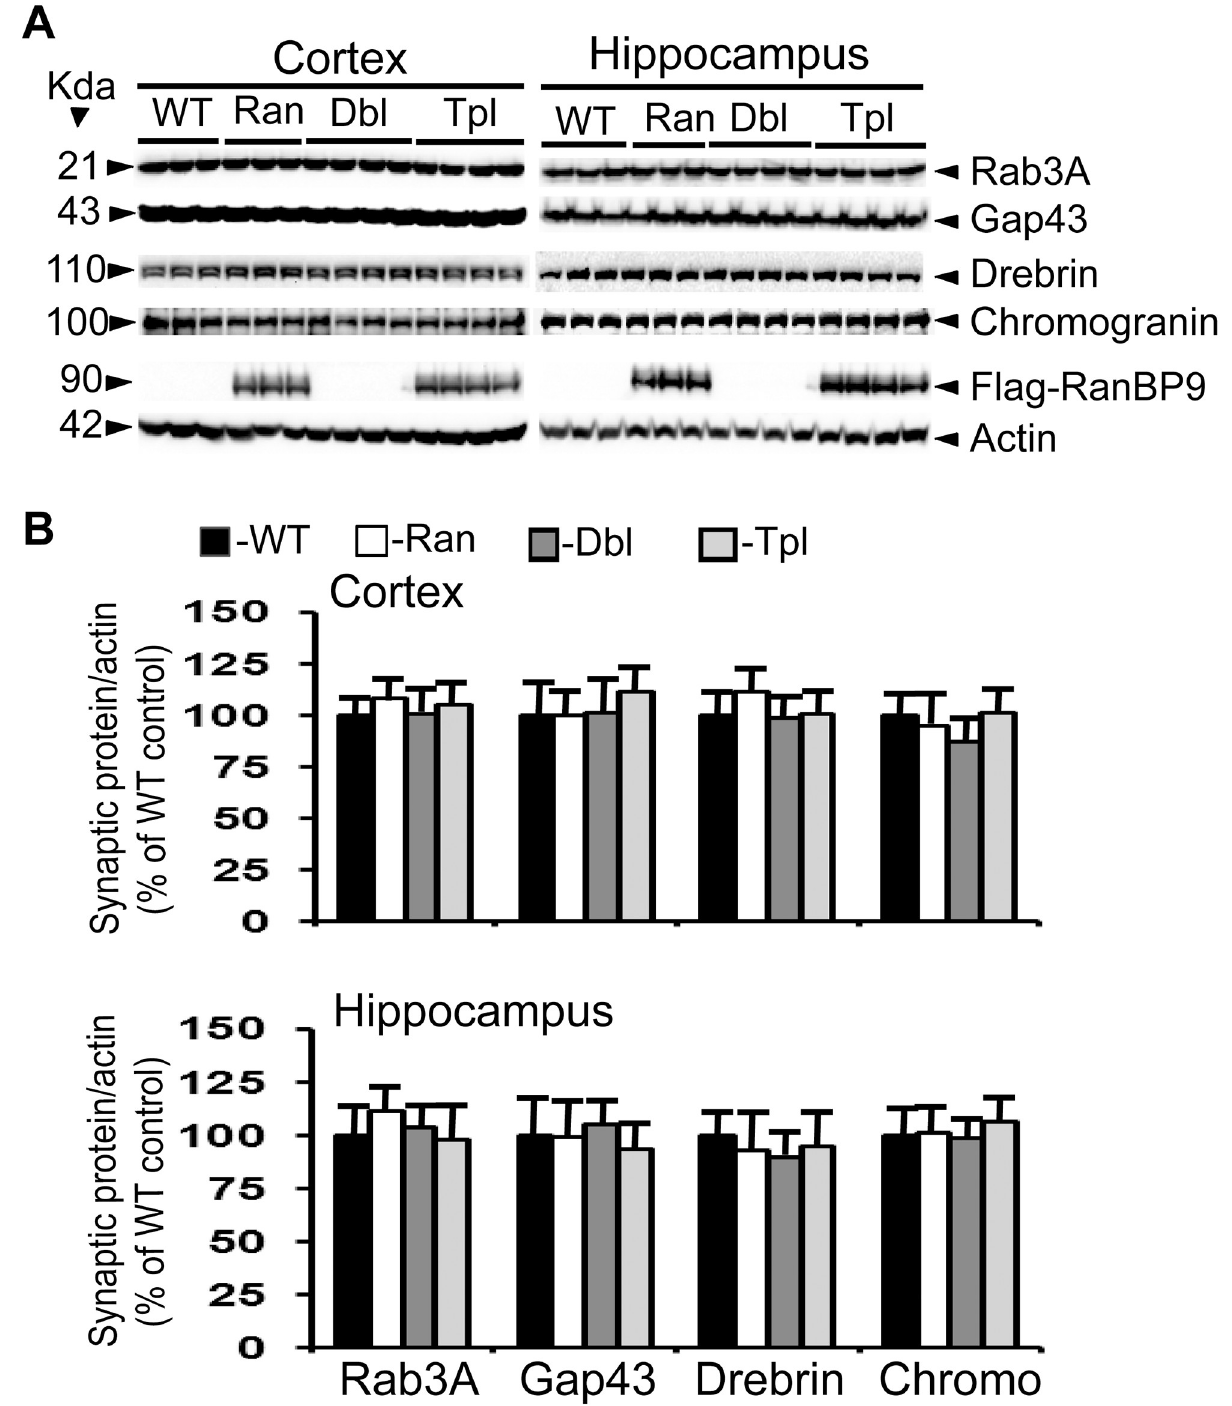
Fig 1. RanBP9 overexpression does not alter synaptic protein levels in the cortex and hippocampus at 3- months of age. A: Shows an immunoblotting analysis of rab3A, gap43, drebrin, chromogranin and the house keeping gene actin in brain samples from cortex and hippocampus. Brain homogenates from RanBP9 transgenic (Ran), AP Δ E9 double transgenic (Dbl), AP Δ E9/RanBP9 triple transgenic (Tpl) and age-matched wild-type (WT) control mice at 3-months of age were subjected to SDS-PAGE electrophoresis and probed with their respective antibodies. Flag specific monoclonal antibody detected flag-tagged exogenous RanBP9 in the RanBP9 single transgenic and AP Δ E9/RanBP99 triple transgenic mice only. Actin was used as loading control. The numbers on the left side indicate the molecular weights of each protein. B: Image J quantitation and normalization to actin levels showed no changes in the levels of any of the synaptic proteins at 3 months. The data are mean ± SEM, n = 3 for WT and RanBP9 single transgenic, and n = 4 for AP Δ E9 and AP Δ E9/RanBP9 genotypes.